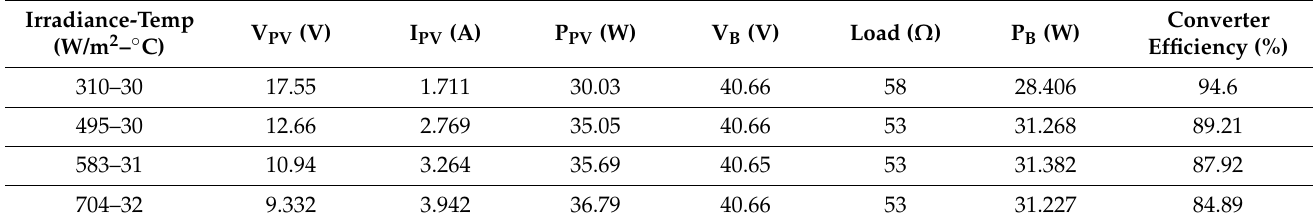
Figure 11. V B at varying irradiance levels from ( a ) simulation and ( b ) experiment. In terms of the voltage regulating range, as briefly described in Section 3.1, the voltage regulating range of the boost converter was not fixed and was directly affected by the solar irradiance and temperature. For instance, using the PV panel given in Table 3, at the irradiance of 800 W/m 2 and temperature of 31 °C, the theoretical maximum V B was